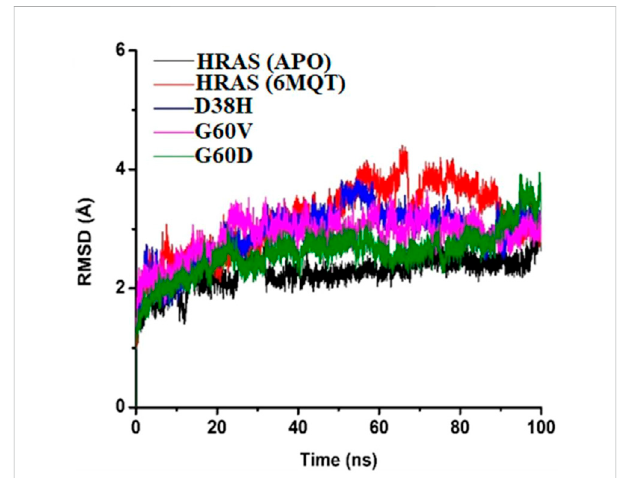
FIGURE 7 TheRMSDoftheAPOproteinwasTheMostStableamongAllthe Protein Models, with a Value of 3.14 Å as Shown in Figure